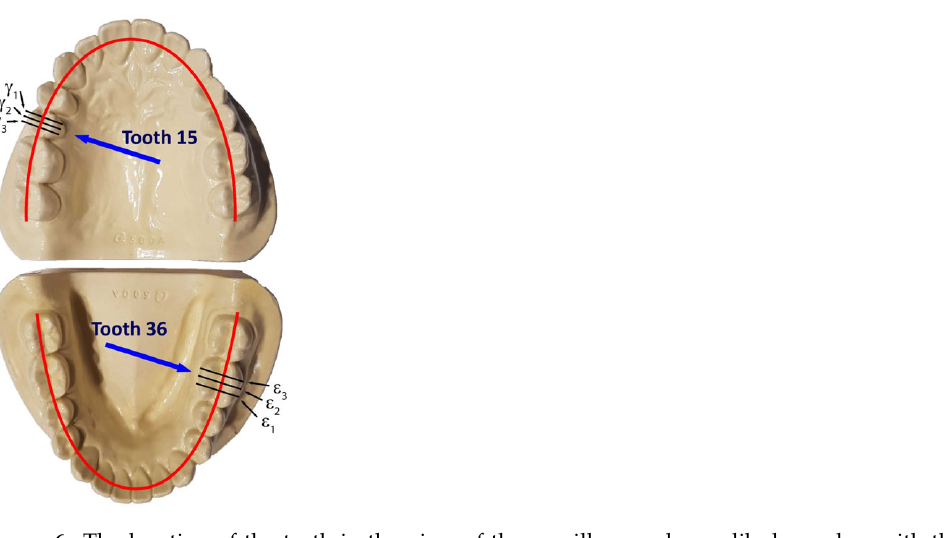
#1, and (5) extension offset (3Shape Dental System 2016 User Manual).